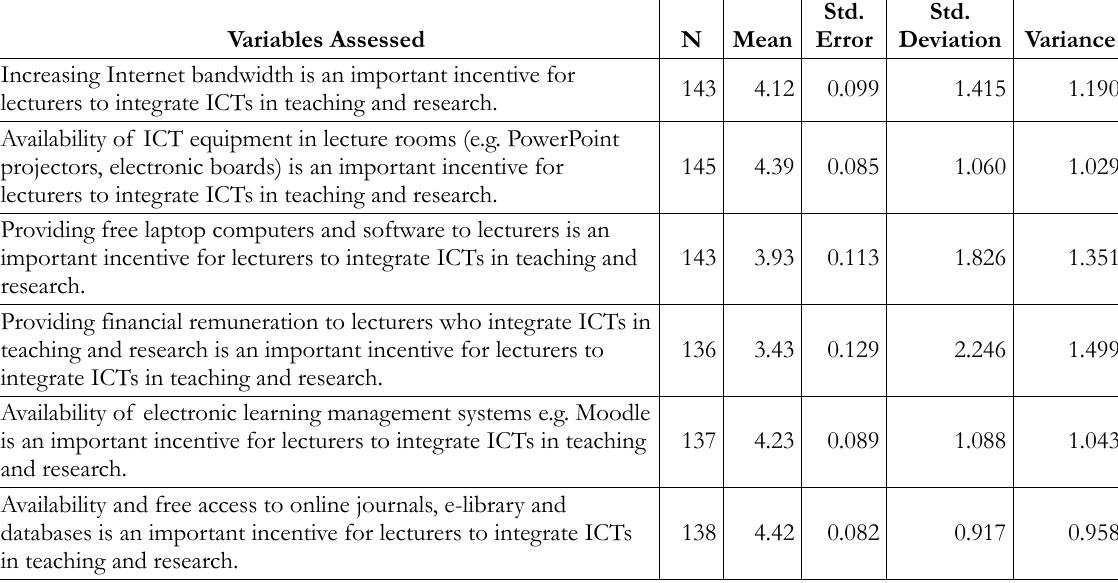
Table 6. Incentives for lecturers to integrate ICTs in teaching and